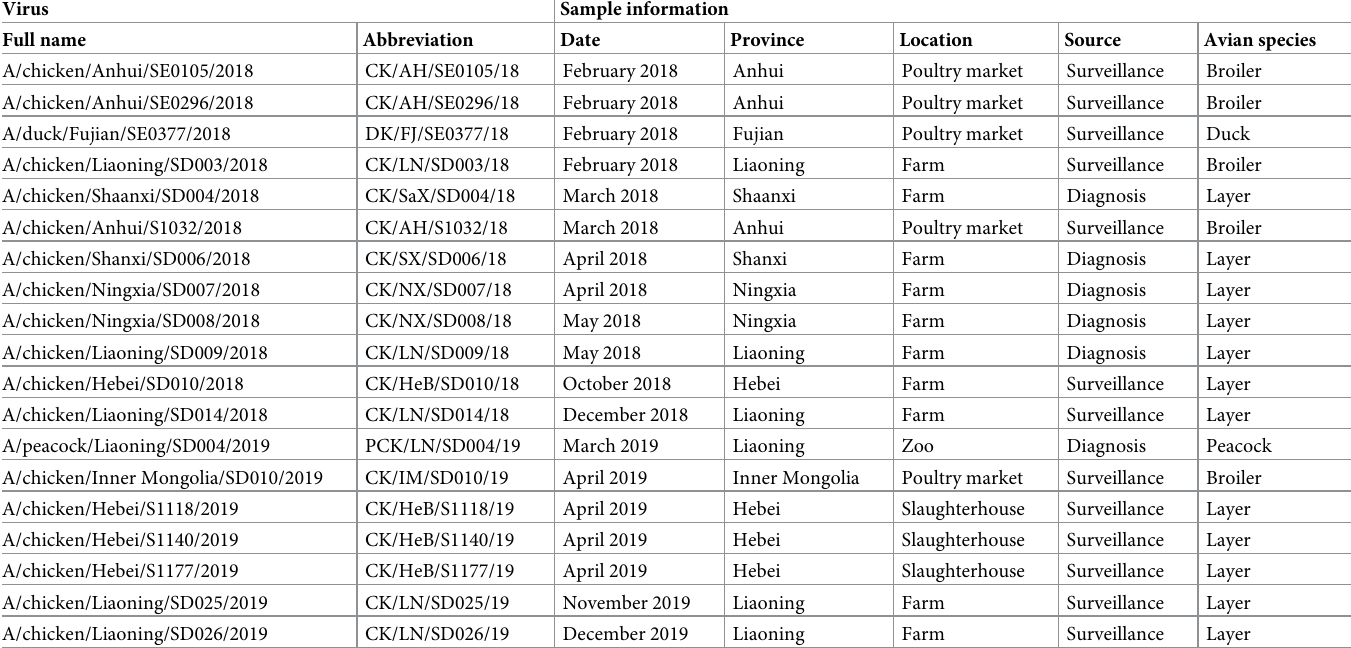
Table 1. H7N9 viruses isolated between February 2018 and December 2019.